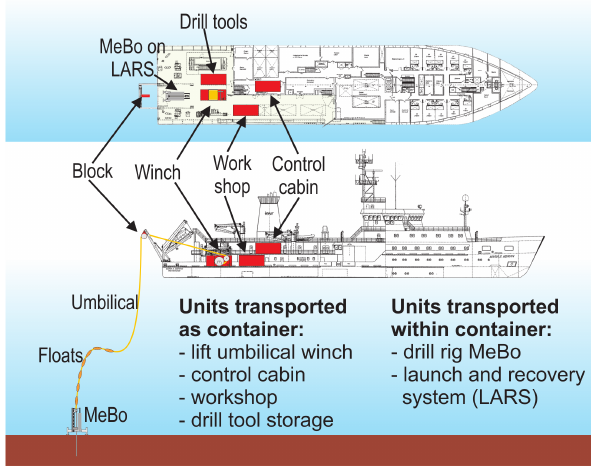
Fig. 1. Typical operational setup for a remote-controlled drill rig that is lowered to the sea floor. As an example, the sea floor drill rig MeBo and the research vessel Maria S. Merian is